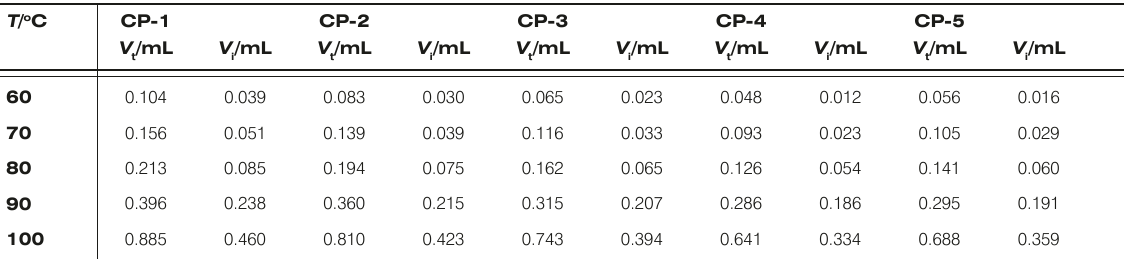
Table 1. Volume of gas produced from total process and isothermal